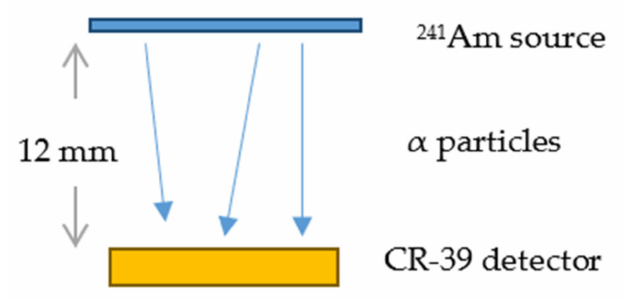
Figure 1. Schematic of 241 Am